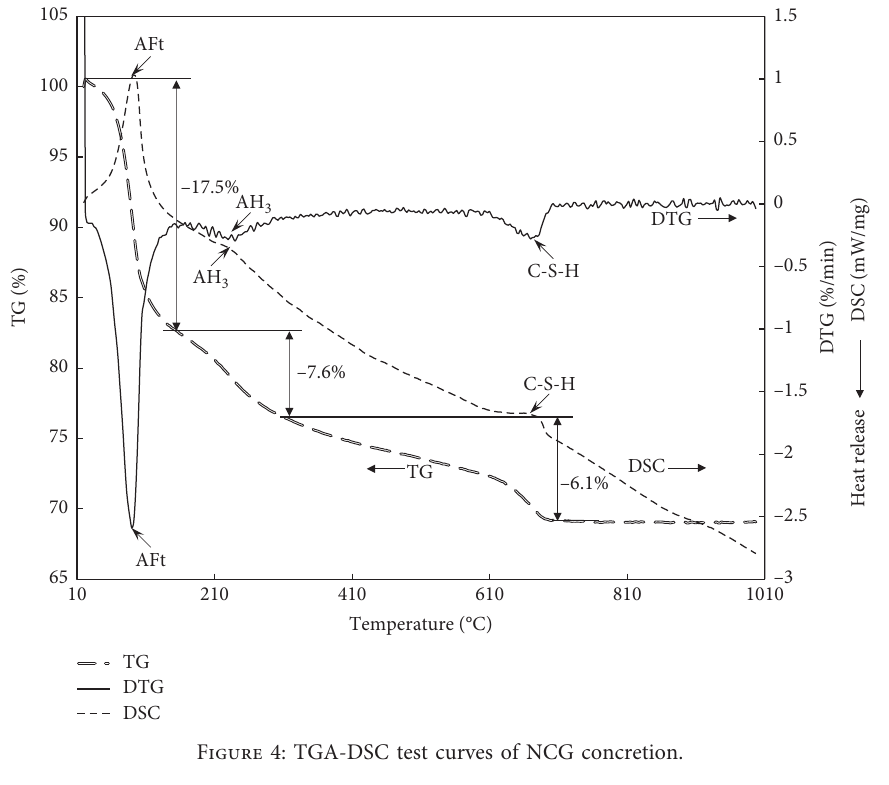
Figure 4: TGA-DSC test curves of NCG concretion.